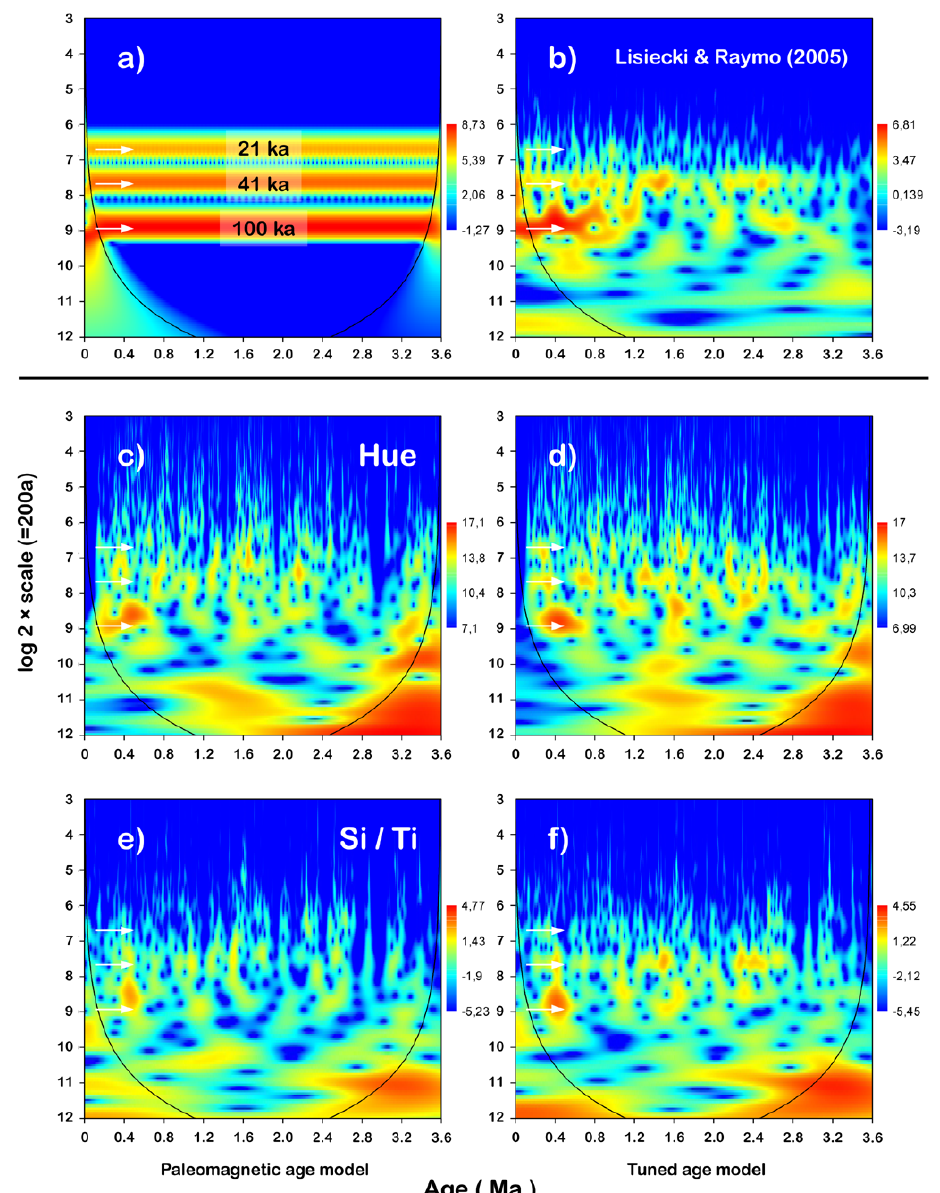
Fig. 11. Wavelet analyses using a Morlet wavelet with a base frequency of 6 and a scale of 200 a performed on some stratigraphic properties from Lake El’gygytgyn used for tuning: (a) persistent mono-frequency sine waves with periods of 21ka (precession, at 6.7145), 41ka (obliquity, at 7.6795), and 100ka (eccentricity, at 8.9658) for reference, (b) the marine oxygen isotope stack by Lisiecki and Raymo (2005) that was used as one tuning reference curve, times series of (c) hue angle of sediment colour and (e) Si/Ti ratio from XRF scanning solely based on magnetostratigraphic dating and the same with fine-tuned age model (d) and (f) . White arrows always mark the positions of the major astronomical periods shown in (a)